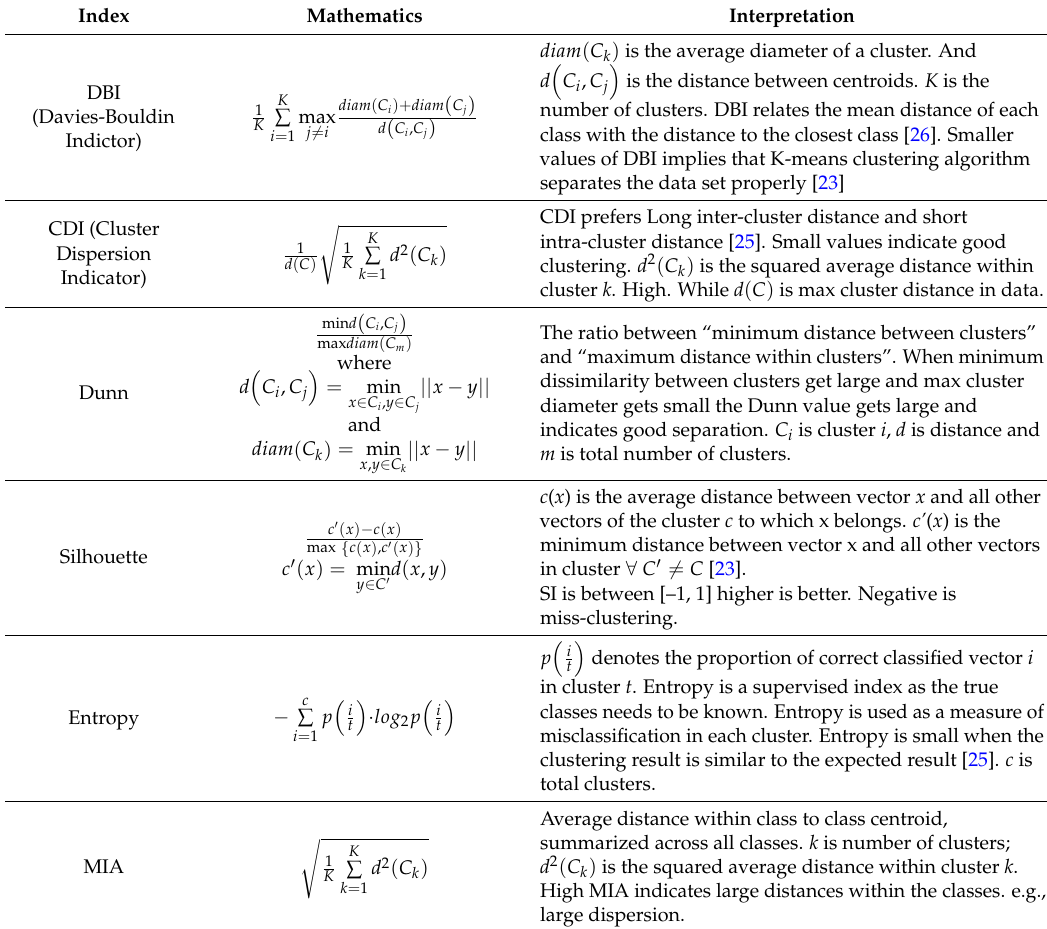
Table 8. Popular cluster validation indices and how to interpret